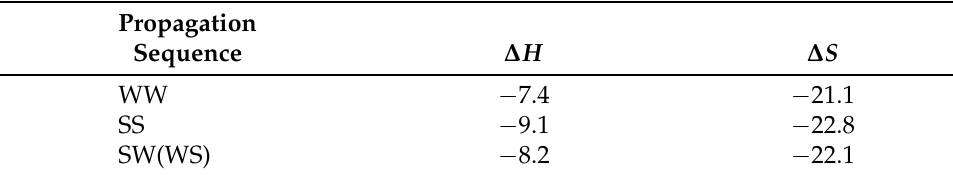
Table A4. Thermodynamic parameters for canonical Watson–Crick base pairs for duplexes made by DNA/DNA averaged over categories of bases. Energy and entropy units are kcal mol − 1 and cal mol − 1 K − 1 , respectively.